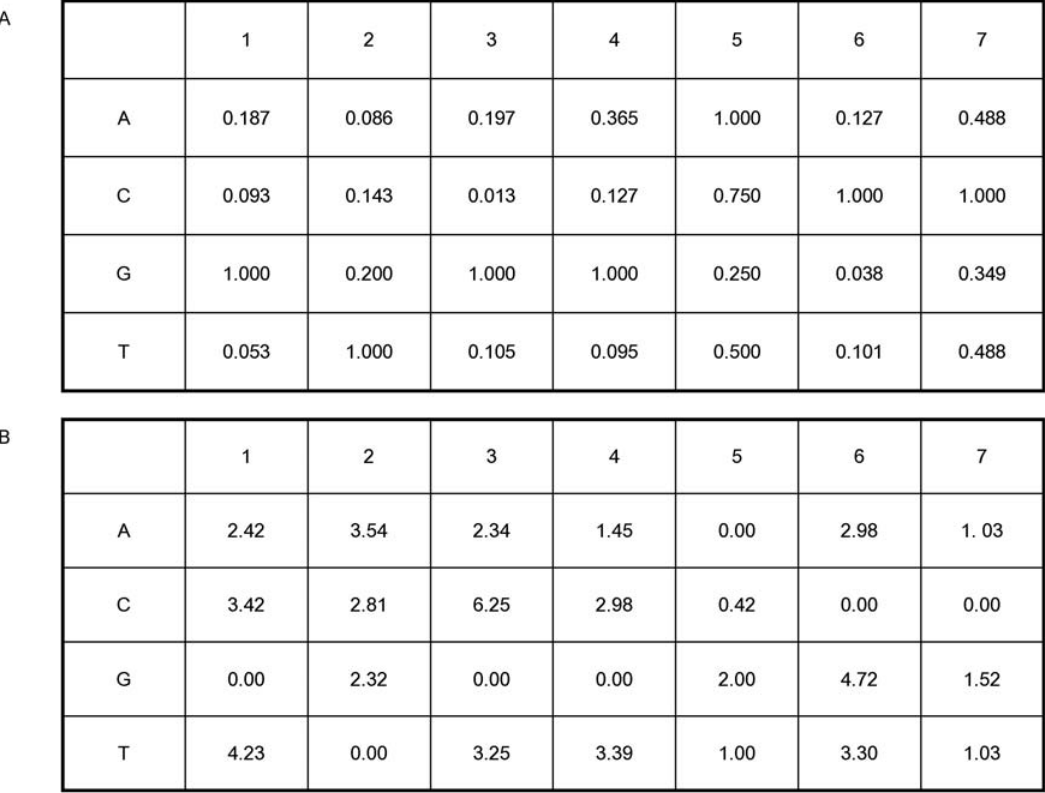
Figure 1. Mnt binding matrices. A. The experimentally observed relative frequency of each type of DNA base at each position in the 7-long Mnt protein half-site. The highest affinity site is: 5 9 -GTGGACC-3 9 . B. The negative log2 of the values shown in A. Each entry represents the binding energy contributed by a particular base at that position in the site to the total binding energy. This matrix represents the ‘‘true’’ binding model.